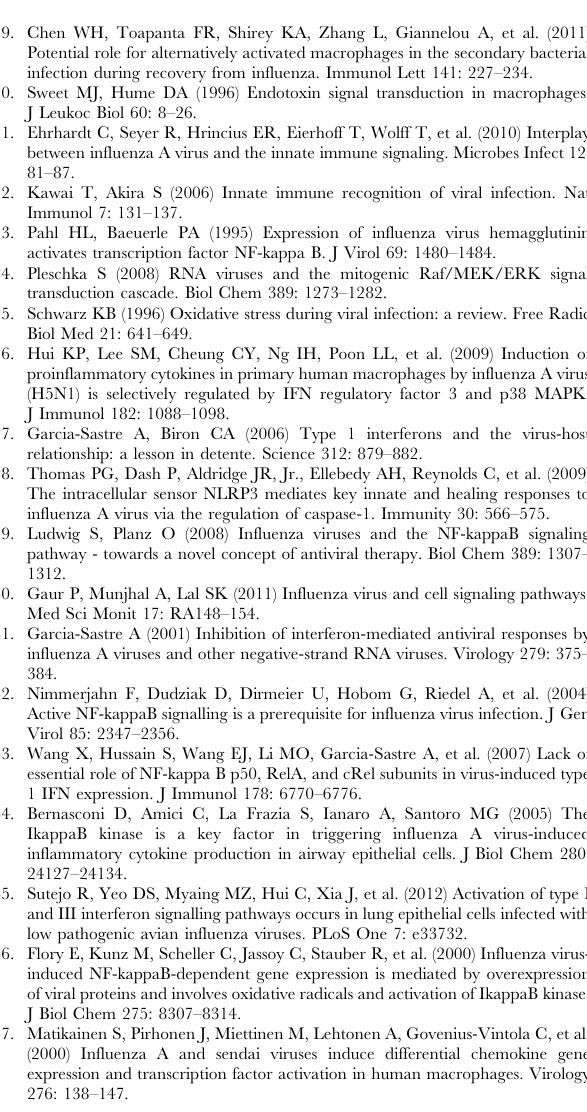
Table S2 Summary of CK/CHK Concentration Changes in Response to MAPK Inhibitors in RAW 264.7